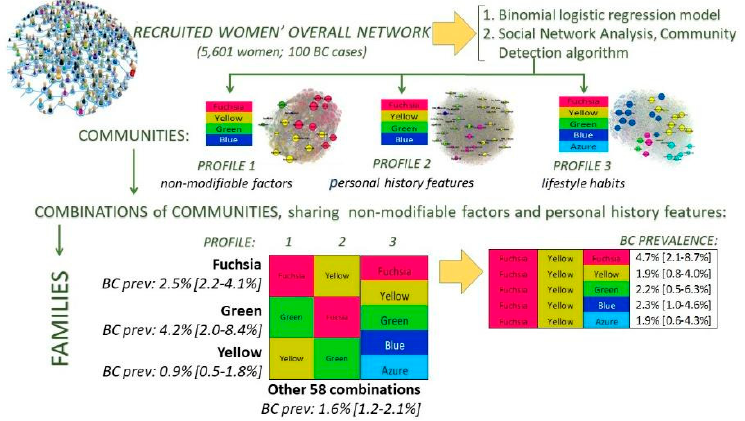
Figure 1. Overview of the statistical analysis